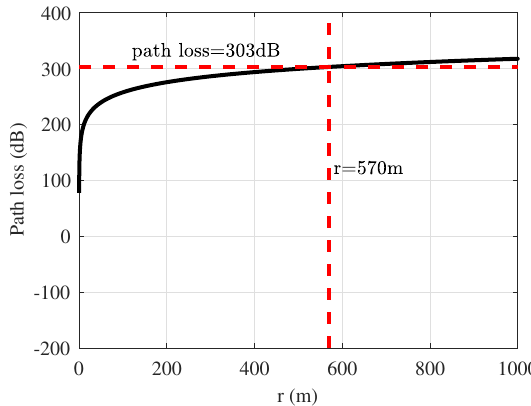
Figure 11. Path loss versus propagation range.